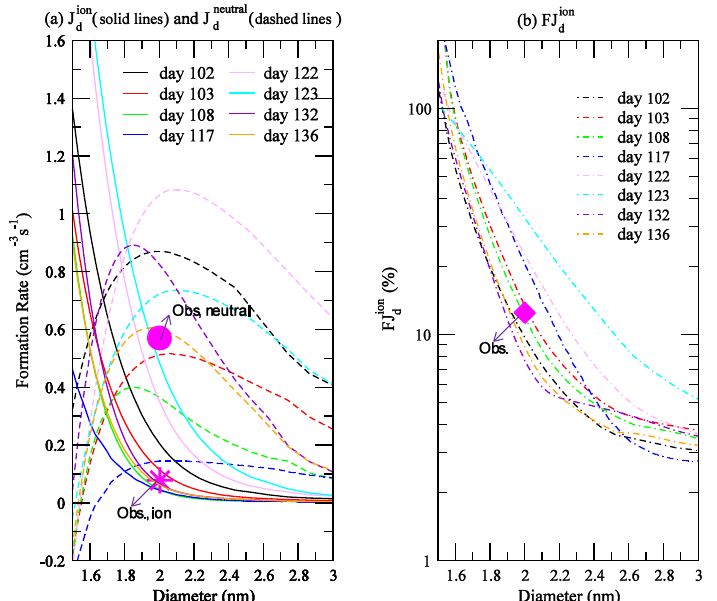
) and neutral ( J neutral ) particles, and the corresponding or J 0 d d d